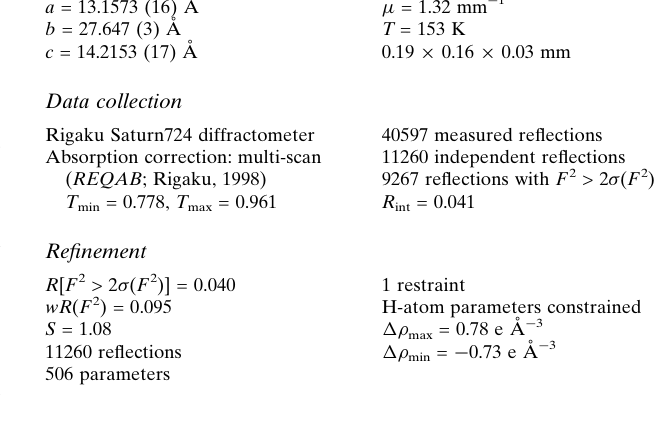
Rigaku Saturn724 diffractometer Absorption correction: multi-scan